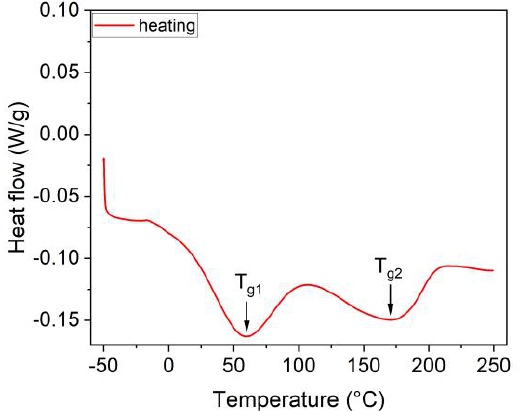
Figure 2. Dependency of heat flow on temperature used for determination of the transition temperatures.